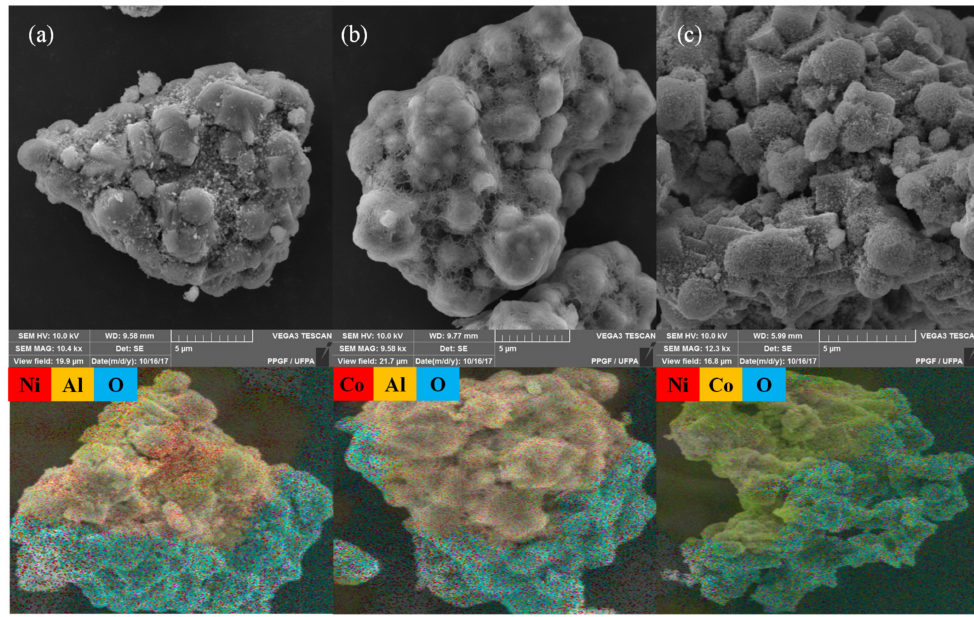
Figure 5. SEM images and EDX elemental mapping of the catalysts. ( a ) NiZeo, ( b ) CoZeo and ( c )